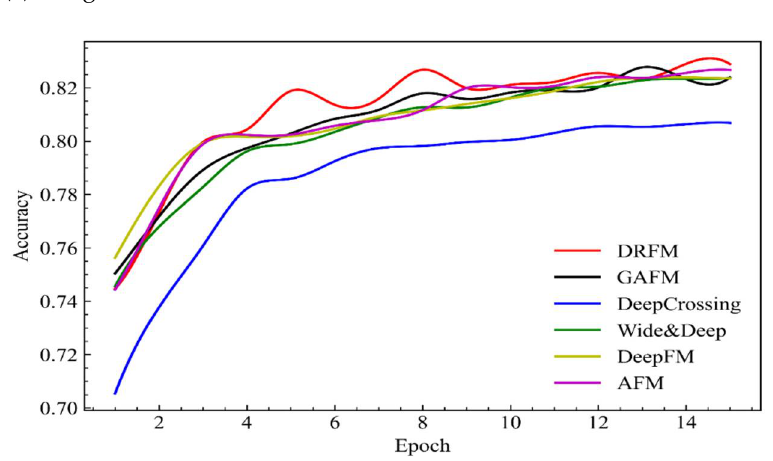
Figure 9. Accuracy of each model in dataset